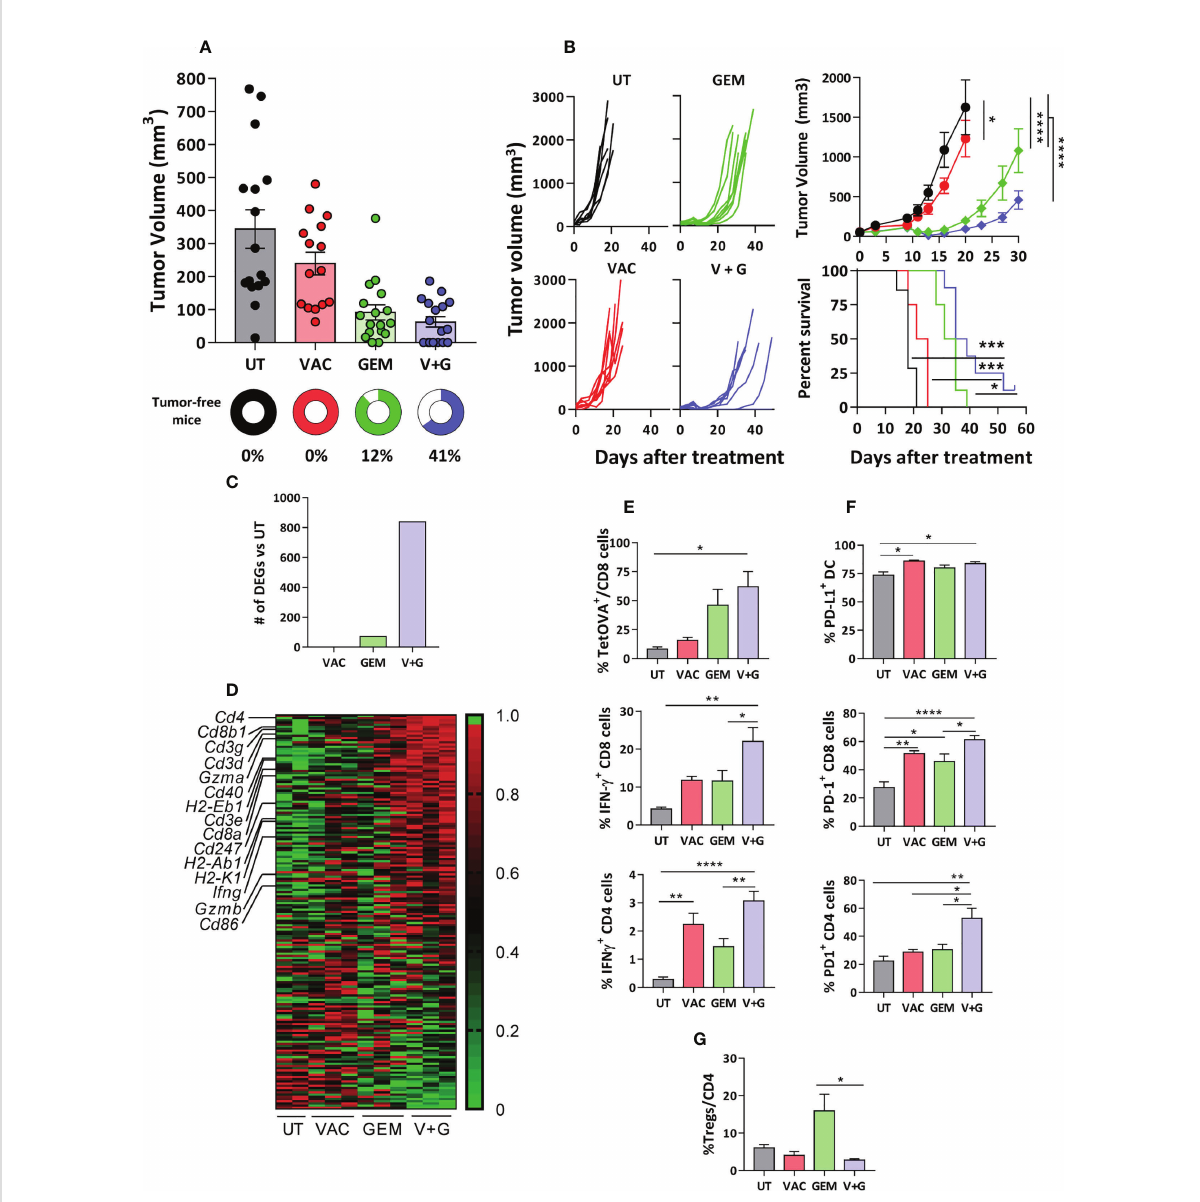
FIGURE 4 Gemcitabine improves the therapeutic effect of vaccination associated with enhanced T-cell immunity. C57BL/6J mice bearing 5-6 mm LLC- OVA tumors were untreated (UT) or treated with OVA + Imiquimod vaccine (VAC), gemcitabine (GEM) or the combination (V+G). (A) Tumor volume and the percentage of tumor-free mice were determined at day 11 of treatment (n=15-17 mice/group). (B) Tumor growth curves and survival were studied in long-term experiments (n=8 mice/group). (C) Representative tumors (n=3/group; except UT, n=2) from mice treated for one week were obtained and gene expression was analyzed by RNAseq. Bars correspond to differentially expressed genes with respect UT mice (FC>2, adjusted P <0.05). (D) Gene expression heatmap corresponding to genes included in the GSEA hallmark dataset “ Allograft rejection ” in the four groups. Tumors (n=5-8/group) were obtained after one week of treatment and % of TetOVA + cells and IFN- g -producing CD8 and CD4 T-cells (E) , PD-L1 + DC and PD-1 + CD8 and CD4 cells (F) and Tregs (G) were determined by fl ow cytometry. Bars show mean + SEM (*, P < 0.05; **, P < 0.01; ***, P < 0.001; ****, P <